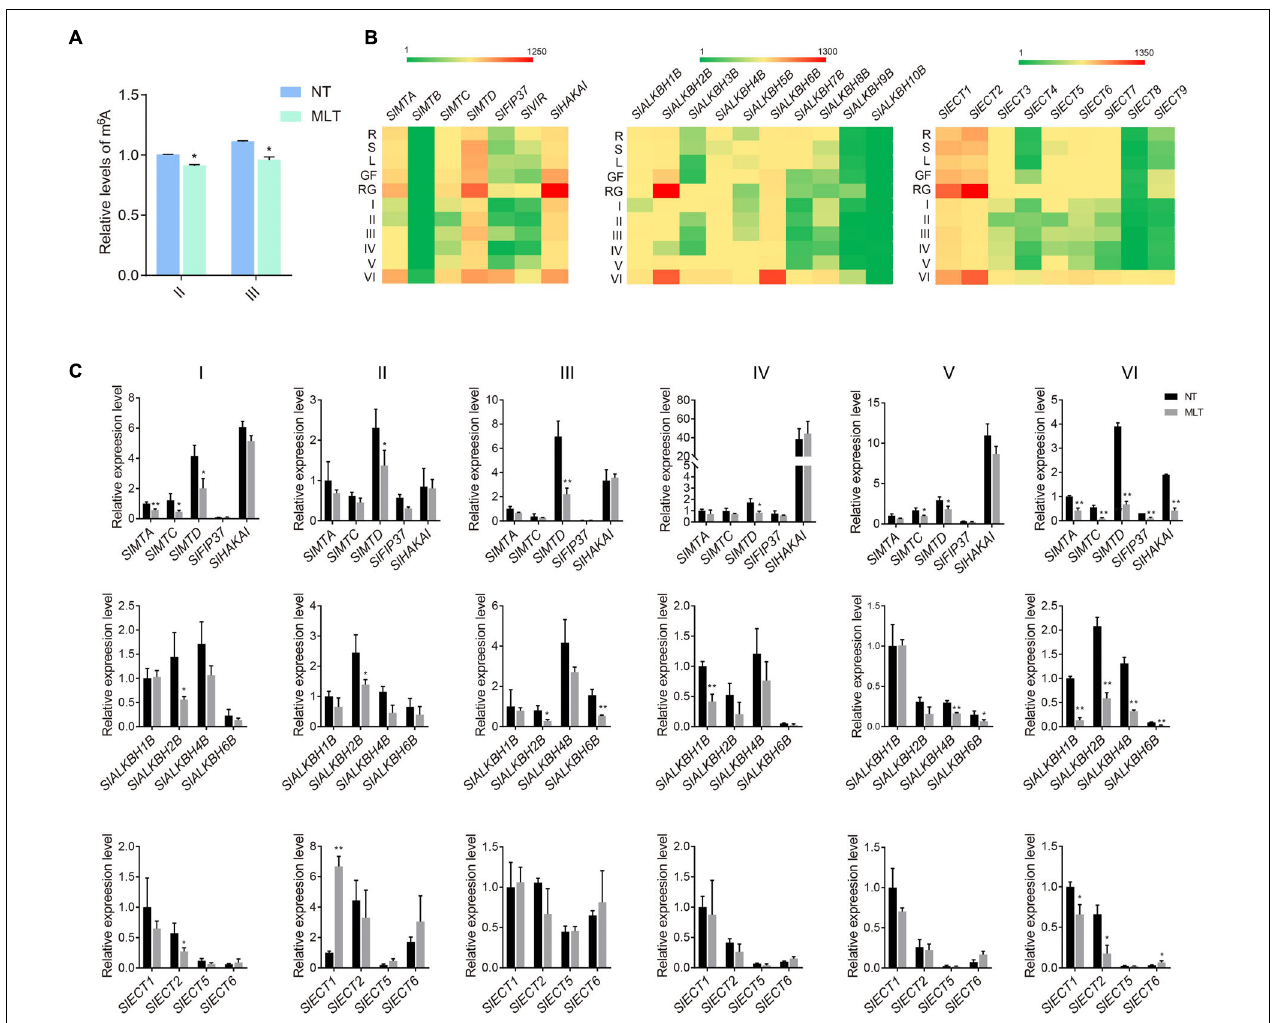
FIGURE 2 | The expression profiles of m 6 A writers, erasers and readers under NT and MLT conditions. (A) The relative levels of m 6 A in total RNA of anther at stage-II and III under NT and MLT conditions. The level of m 6 A in stage-II under NT condition is set to 1. Each value is the mean ± SD ( n = at least three biological replicates with 15 plants each). * P < 0.05; ** P < 0.01 (two-tailed Student’s t- test). (B) Expression patterns of genes in various tissues of plants under NT condition, especially in anther of different stages. Green, weak expression; Red, strong expression. R, root; S, stem; L, leaf; GF, green fruit; RF, red fruit; I, anther at microspore mother cell stage; II, anther at tetrad stage; III, anther at early uninucleate stage; IV, anther at late uninucleate stage; V, anther at binucleate stage; VI, anther at mature pollen stage. (C) qRT-PCR analysis of writer, erasers and readers genes in anther at different stages under NT and MLT conditions. The levels of genes expression normalized to Ubiquitin expression are shown relative to SlMTA , SlALKBH1B , and SlECT1 under NT condition set to 1, respectively. Each value is the mean ± SD ( n = at least three biological replicates with 15 plants each). * P < 0.05; ** P < 0.01 (two-tailed Student’s t-